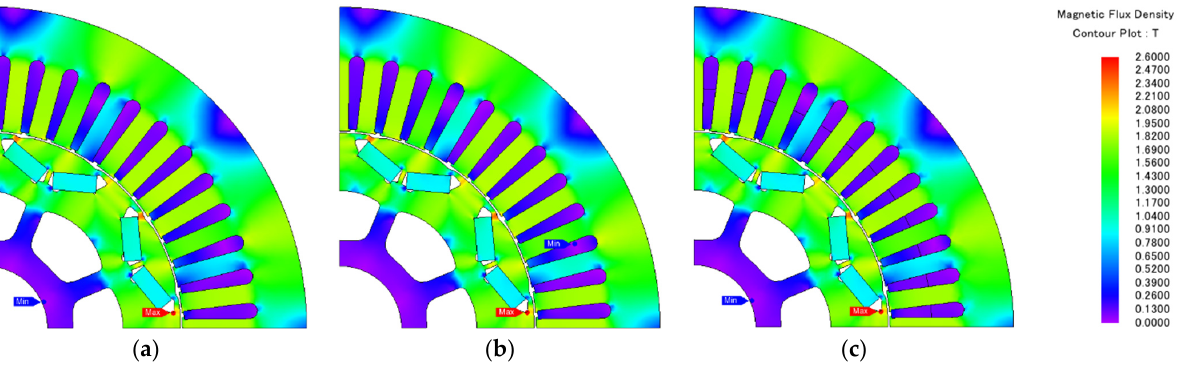
Figure 20. Flux density distributions of different winding configurations at I A = 236 Apk, β = 0°: ( a ) ORG; ( b ) DTP-SF; ( c ) DTP-DS.